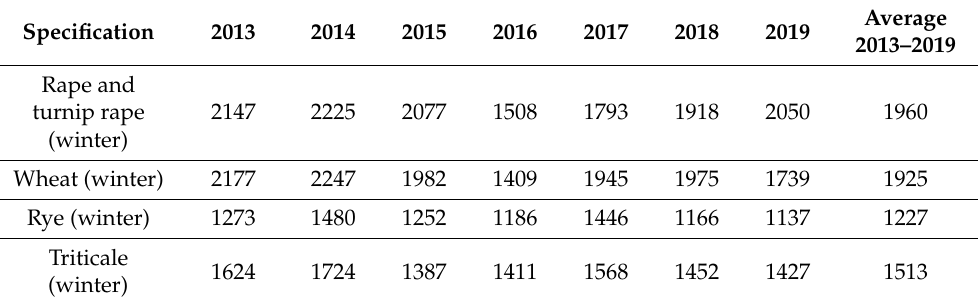
Table 6. Income from production of winter rape and colza, rye, triticale, and wheat in 2013–2019